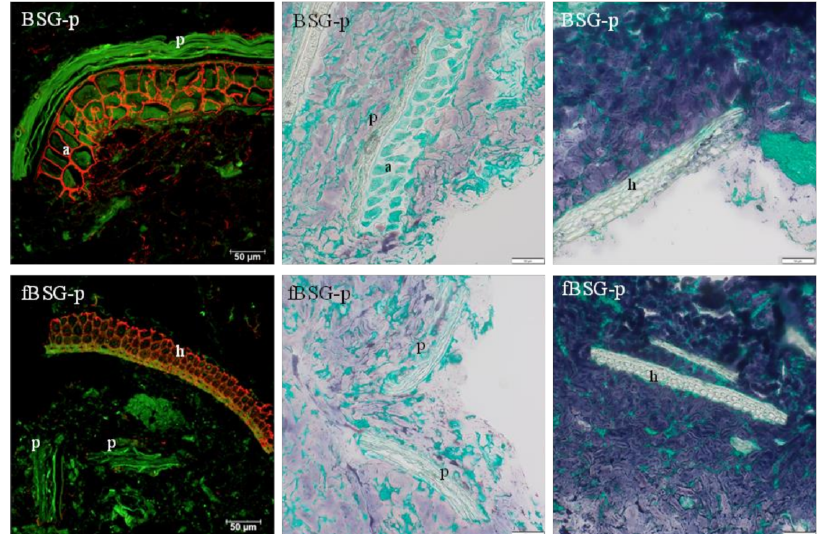
Figure 3. CLSM (left) and brightfield (middle, right) micrographs of pasta containing fermented and native brewers’ spent grain: BSG-p, pasta containing native brewers’ spent grain; fBSG-p, pasta containing fermented brewers’ spent grain. In CLSM micrographs arabinoxylan is shown in red and autofluorescence (cell walls, protein) is shown in green. Bright field micrographs show starch in blue and protein in green. h= hull (palea and lemma), a = aleurone, p = pericarp. Scale bars 50 µ